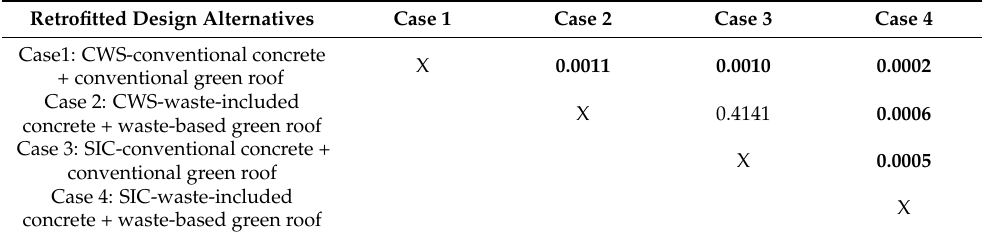
Figure 11. ( A ) Case 1: concrete wall strengthening (CWS)-conventional concrete + conventional green roof, ( B ) Case 2: CWS-waste-included concrete + waste-based green roof, ( C ) Case 3: seismic isolation columns (SIC)-conventional concrete + conventional green roof, and ( D ) Case 4: SIC-waste-included concrete + waste-based green roof evaluated with ReCiPe 2016 endpoint single-score method. Table 10. p -values of the differences in single-score evaluation between pairs of four retrofitted design alternatives for the life-cycle assessment (LCA) (production stage). The LCAs were evaluated via the six ReCiPe2016 single-score methodological